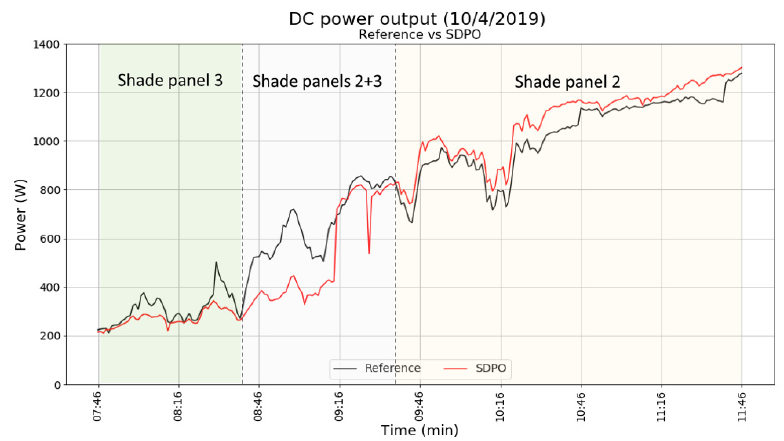
Figure 7. Comparison of the output of the systems when pole shading moves gradually from a panel without SDPO to a panel with SDPO.